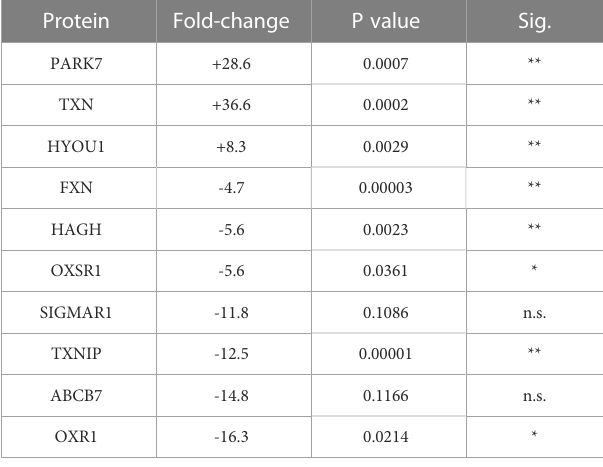
TABLE 3 Effect of tBHP on proteins involved in response to oxidative stress. Protein Fold-change P value Sig.